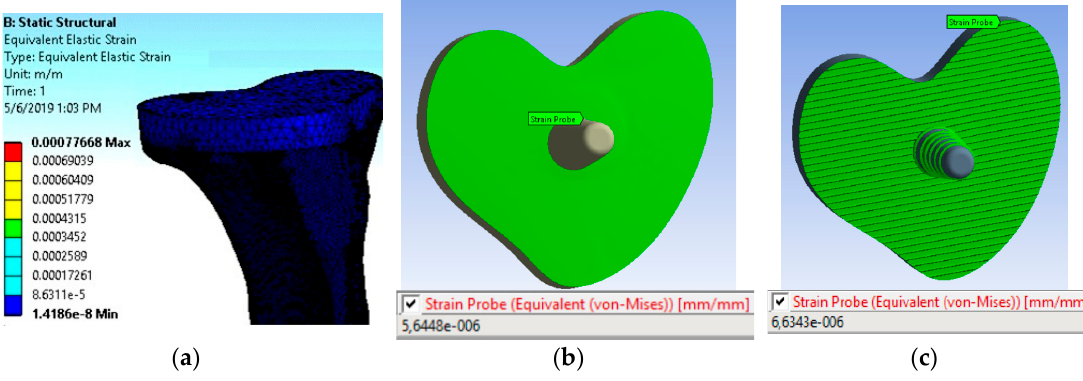
Figure 12. Computation analysis of the TT–bone model after 11,000 cycles. ( a ) Equivalent Von Mises strain contour plot of the entire TT–bone sample. Von Mises strain along the TT–bone interface on ( b ) smooth and ( c ) grooved samples.